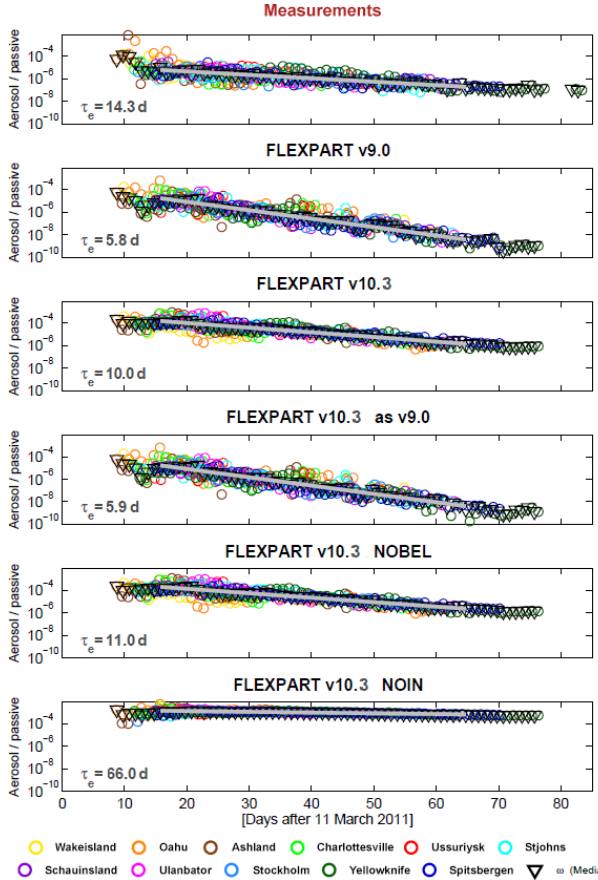
Figure 2. Aerosol lifetimes estimated from the decrease in radionu- clide ratios (aerosol-bound 137 Cs and noble gas 133 Xe as a passive tracer) with time after the Fukushima nuclear accident, as measured and modeled at a number of global measurement stations. For de- tails on the method, see Kristiansen et al. (2016). E -folding life- times, τ e , are estimated based on fits to the data and reported in each panel. In the top panel, the observed values are shown and in subsequent panels from the top, modeled values are given for FLEXPART v9, FLEXPART v10.4, FLEXPART v10.4 with param- eter settings to emulate removal as in v9, FLEXPART v10.4 with no below-cloud removal and FLEXPART v10.4 with no in-cloud